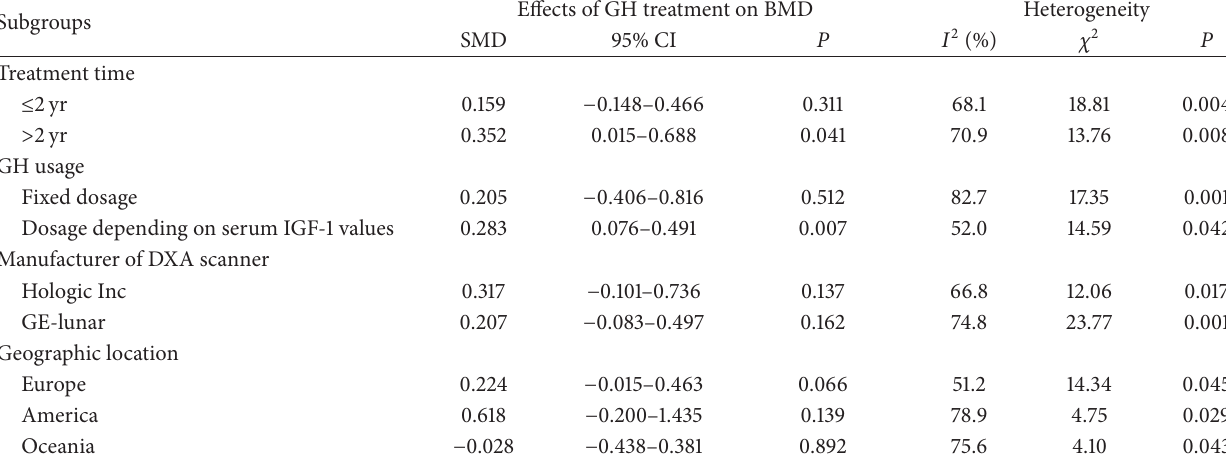
Table 5: Subgroup analyses results of the association between GH treatment and BMD of